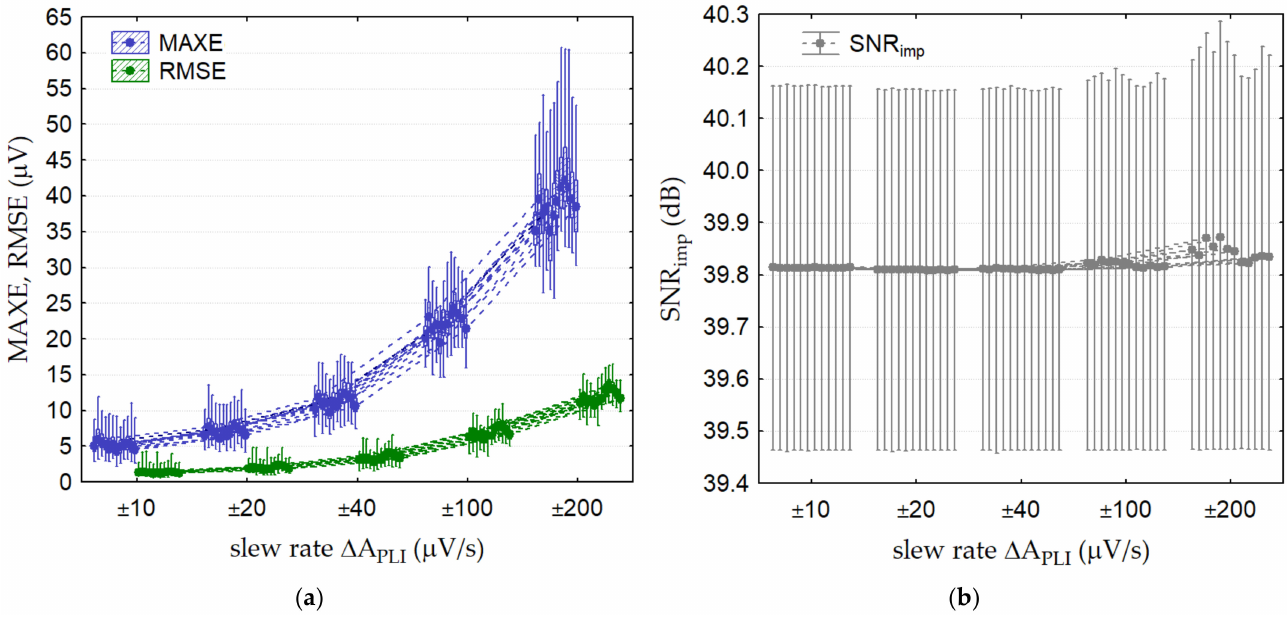
Figure 13. SF algorithm performance for PLI linear amplitude change, computed for 10 s 12-lead ECG from the PTB Diagnostic ECG database and added PLI sinusoid with settings according to Table 2 (Test 4). The boxplots (median; box: 25–75%; whisker: min–max) represent: ( a ) MAXE and RMSE, ( b ) SNR imp ordered for 12 ECG leads (from left to right): I, II, III, avR, avL, avF, V1, V2, V3, V4, V5,